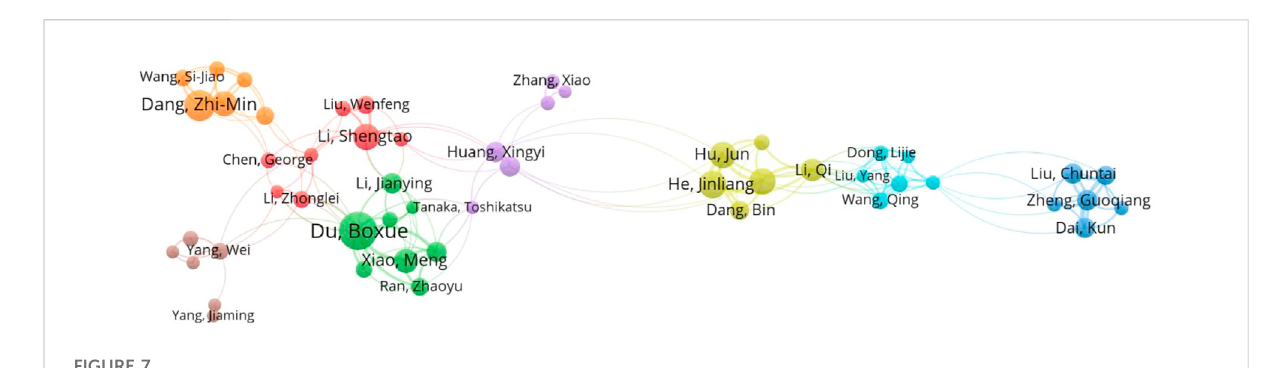
FIGURE 7 Clustering analysis of core